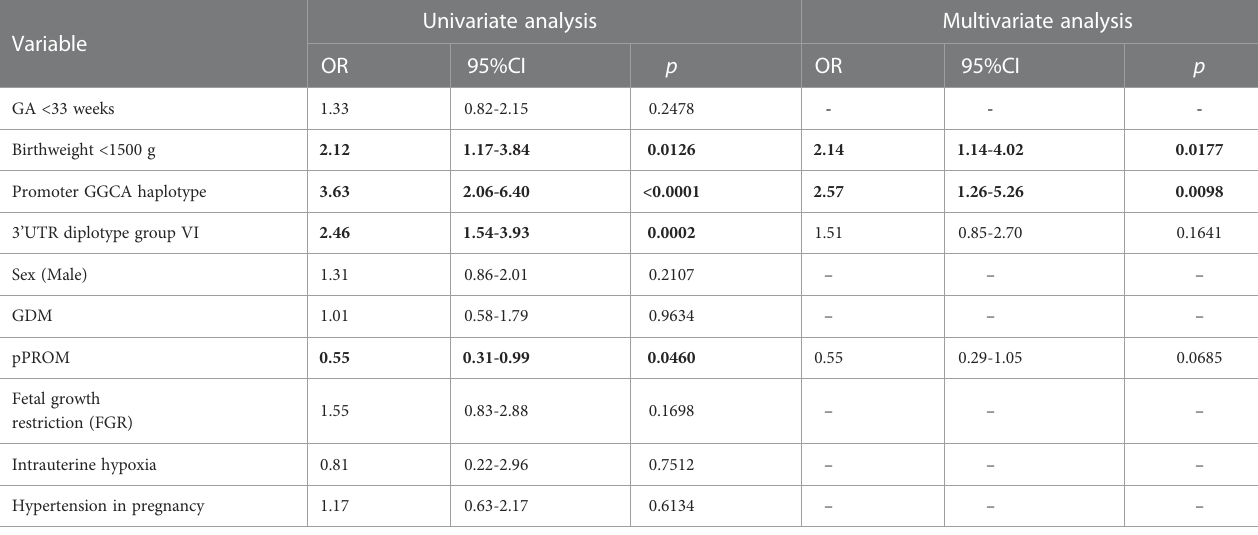
TABLE 2 Univariate and multivariate 1 regression analysis of potential factors for low fi colin-2 concentration (below 25 th percentile) 2 in the whole